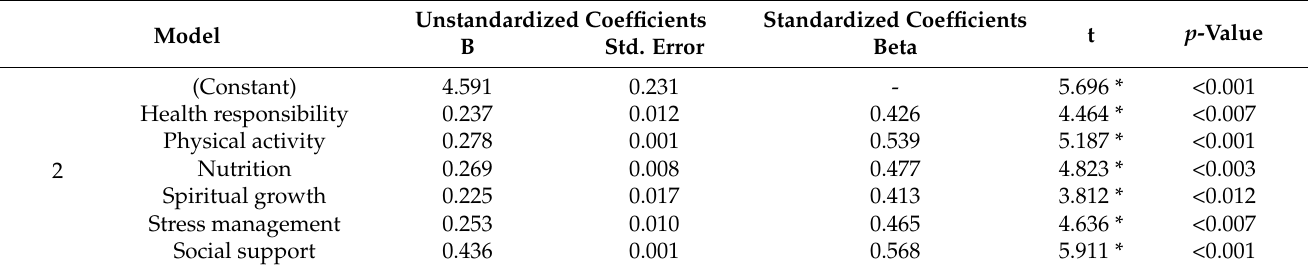
Table 10. Social support coefficients of EGa for multiple regression model